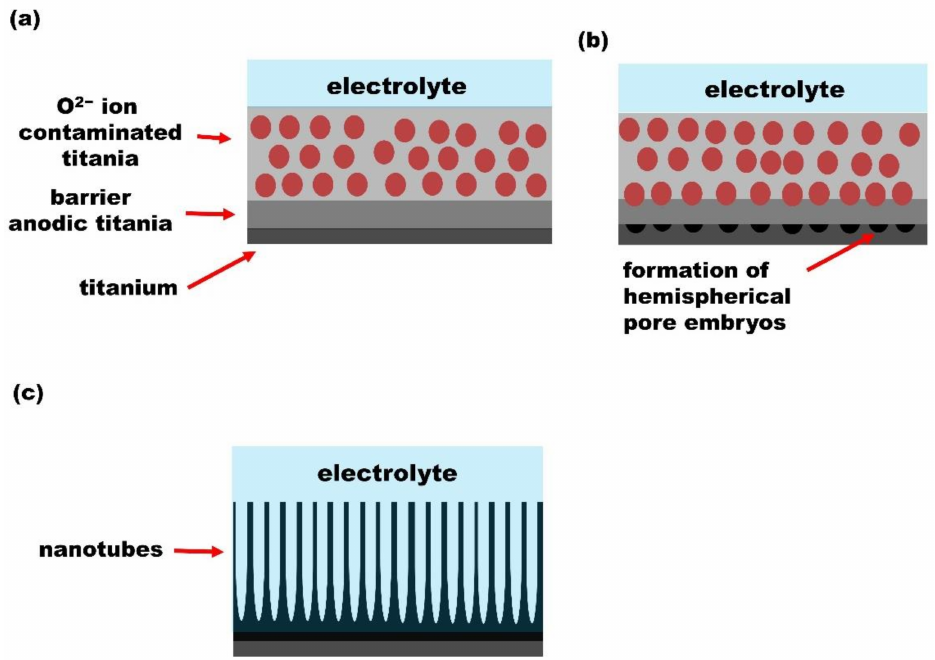
Figure 8. Schematic diagram of oxygen bubble model. ( a ) Formation of the anion-contaminated oxide layer near the electrolyte. ( b ) Formation of hemispherical shape for pores bottom. ( c ) Upward growth of the tube wall due to the volumetric expansion of